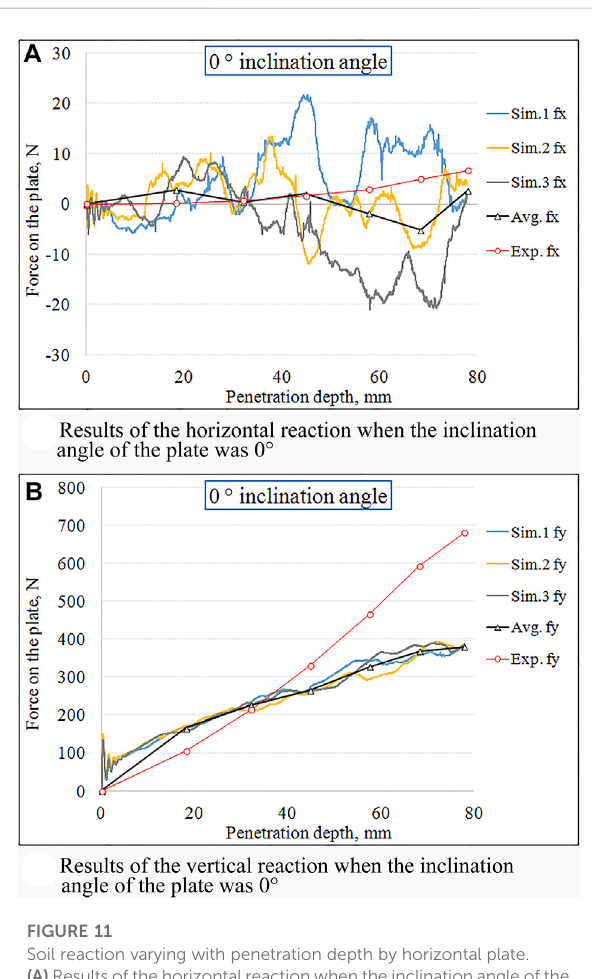
FIGURE 11 Soil reaction varying with penetration depth by horizontal plate. (A) Results of the horizontal reaction when the inclination angle of the plate was 0 ° . (B) Results of the vertical reaction when the inclination angle of the plate was 0 ° .